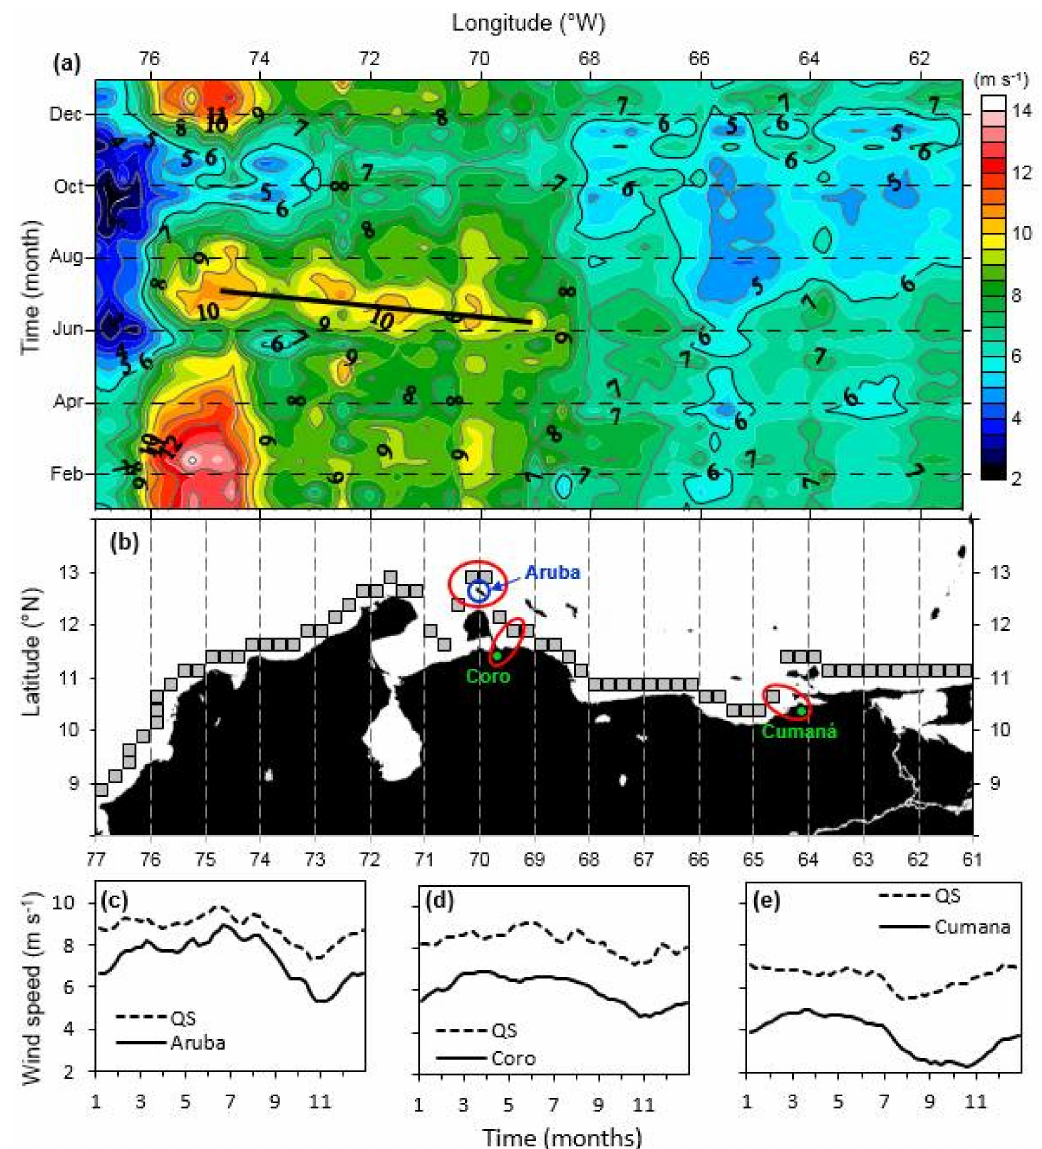
Figure 5. Seasonal cycles of nearshore satellite and land-based coastal wind. ( a ) Seasonal cycle in satellite-derived nearshore wind speed along the southern Caribbean Sea coast, calculated with long-term weekly means of QuikSCAT winds (1999–2009, 0.25 ◦ spatial resolution). During the mid-year upwelling, there was a 3-week westward lag in the wind intensity between 69 ◦ W and 75 ◦ W (solid black line). ( b ) Sampling locations for satellite nearshore winds, with 0.25 ◦ spatial resolution (gray squares). ( c – e ) Two mainland coastal stations (Coro and Cuman á , green circles), one island coastal station (Aruba, blue circle), and their closest QuikSCAT pixels (red ovals) were used to compare weekly nearshore satellite-derived wind data with weekly land-based wind data. Data was centered in the middle of the week; hence, values at 12.88 months are for the last week of December. Land-based measurements for Cuman á (1999–2008), Coro, and Aruba (1999–2007) were obtained from the National Climatic Data Center